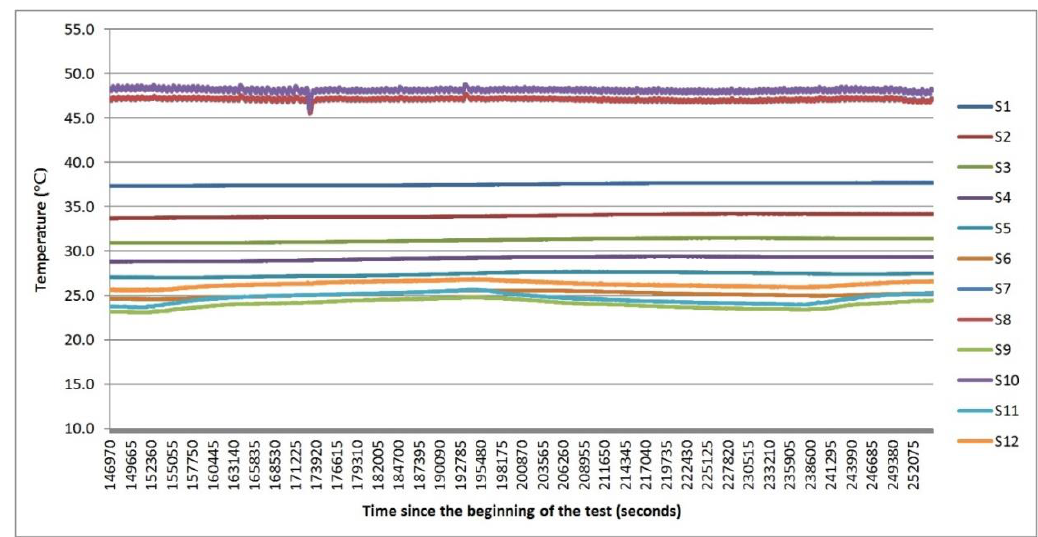
Figure 10. Corrected temperature measurements in the permanent regime by applying the correction factors on sensors S1–S10. (Note that S7 measurements are hidden due to their coincidence with the measurements from S8).